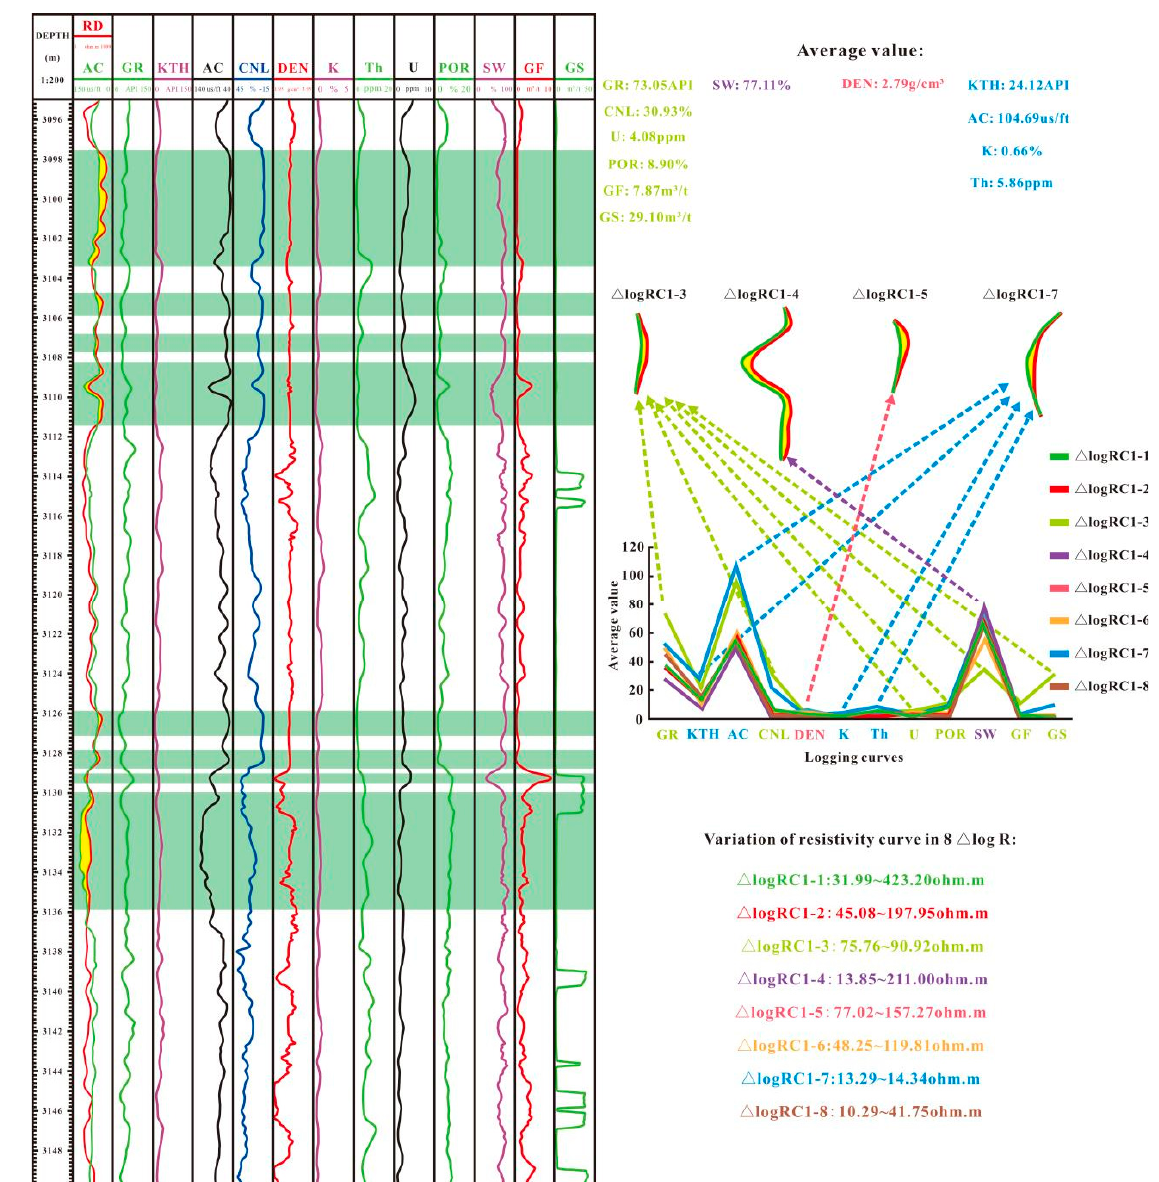
Figure 7. ∆ Log R of well C1 and the average of the corresponding reservoir parameters. Table 12. Actual logging data corresponding to ∆ logR1-3, ∆ logR1-4 ∆ logR1-5, and ∆ logR1-7 in C1 well.